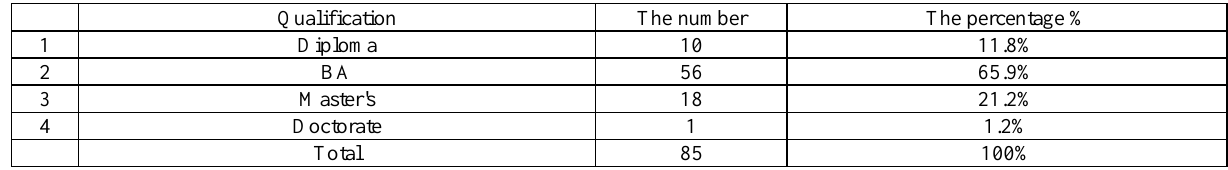
Table 6. Distribution of members of the study sample according to the educational qualification Qualification The number The percentage % 1 Diploma 10 11.8% BA 65.9% Master's 21.2% Doctorate 1 1.2% Total 85 100%